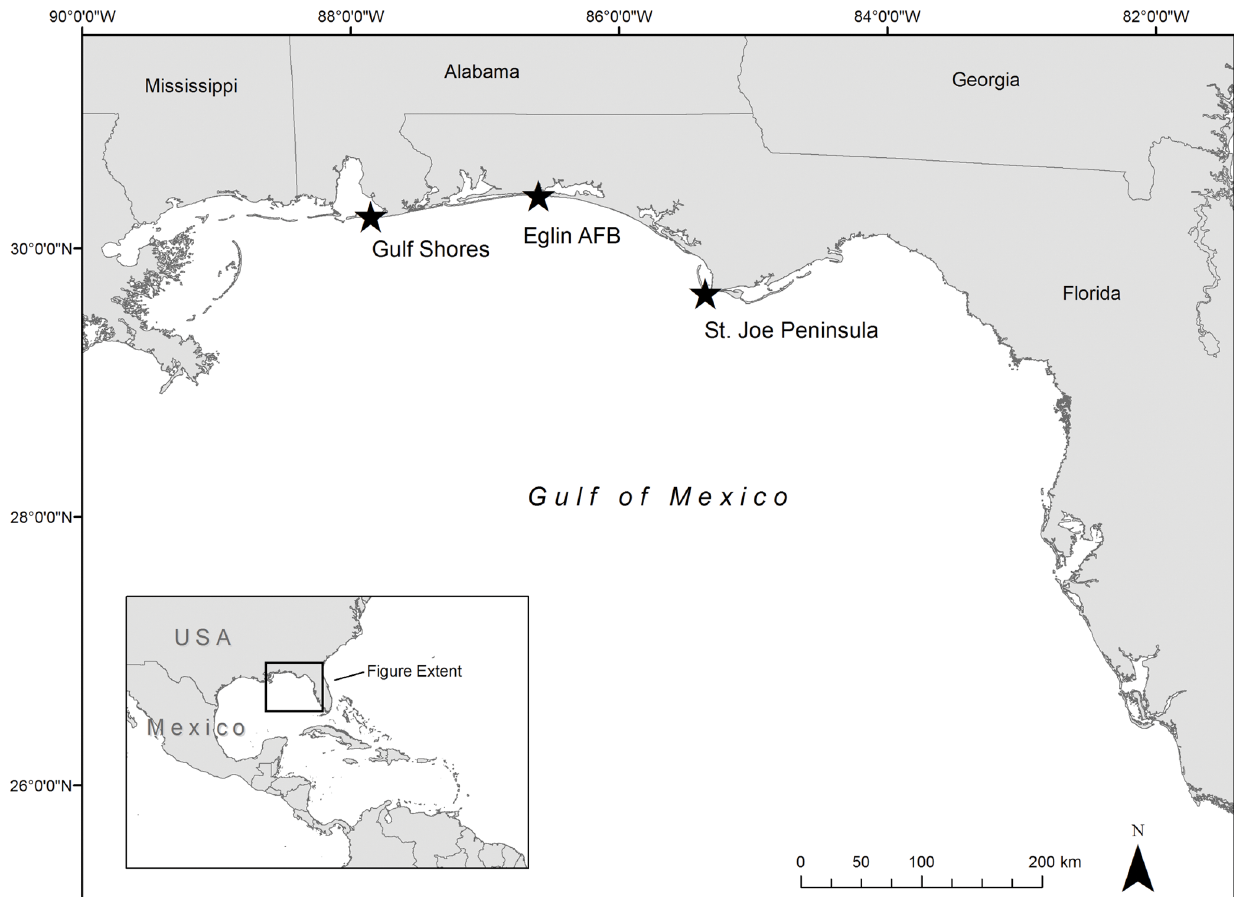
Figure 1. Study sites (stars) where adult female loggerheads ( Carettacaretta ) were intercepted, sampled, and satellite-tagged in 2010 (n=4), 2011 (n=13), and 2012 (n=23).